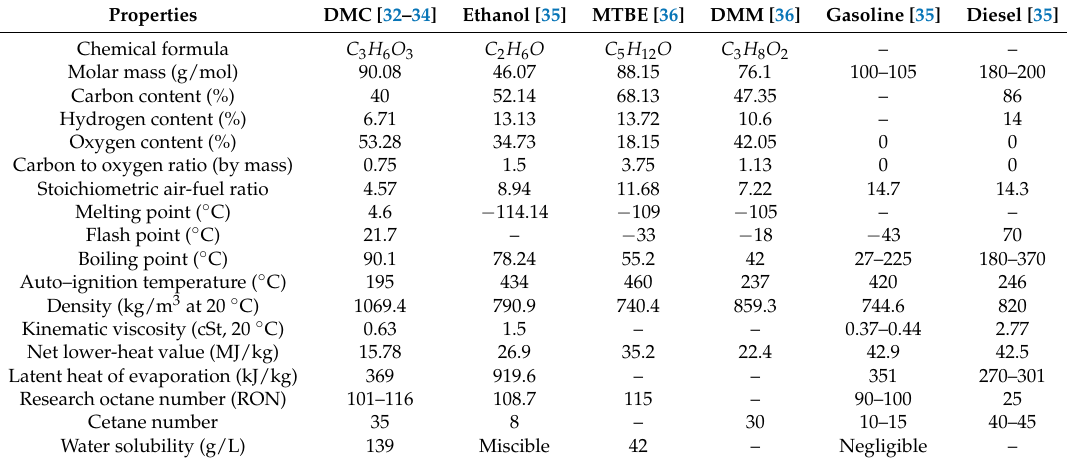
Table 1. The main properties of DMC, other oxygenated, and conventional